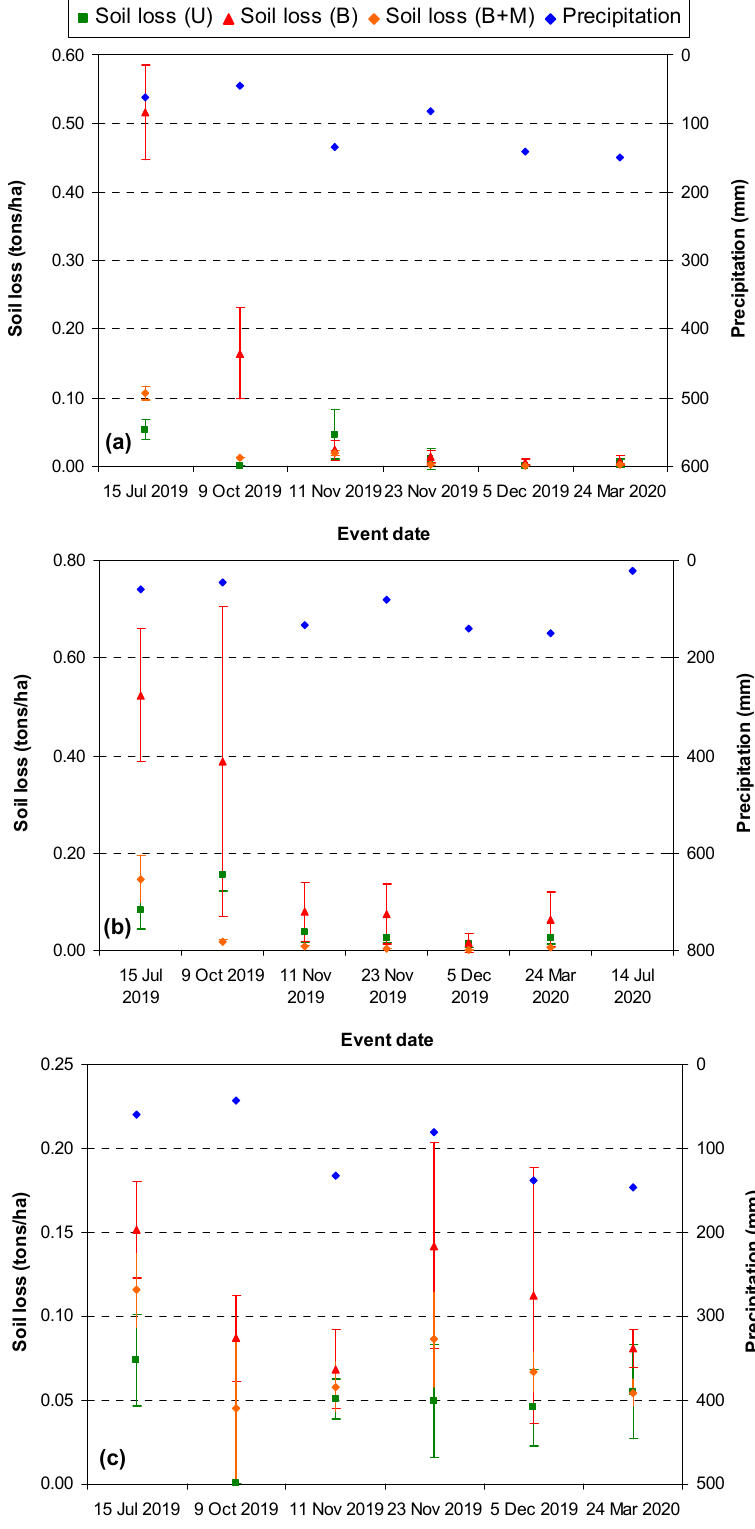
Figure 4. Precipitation and soil loss (mean ± std. dev., n = 3 plots) measured in plots (( a ), pine; ( b ), chestnut; ( c ), oak) after prescribed fire and soil mulching using fern. Notes: U = unburned soils; B = burned and not treated soils; B + M = burned and mulched soils; no soil loss was observed in pine and oak plots on 14 July